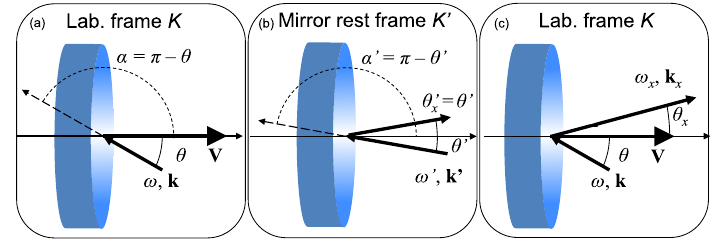
Figure 1. The light reflection by an inclined flying mirror. ( a , c ) are shown in the laboratory frame and ( b ) is in the mirror rest frame. k is the wave vector and prime ( (cid:48) ) denotes the variables in the rest